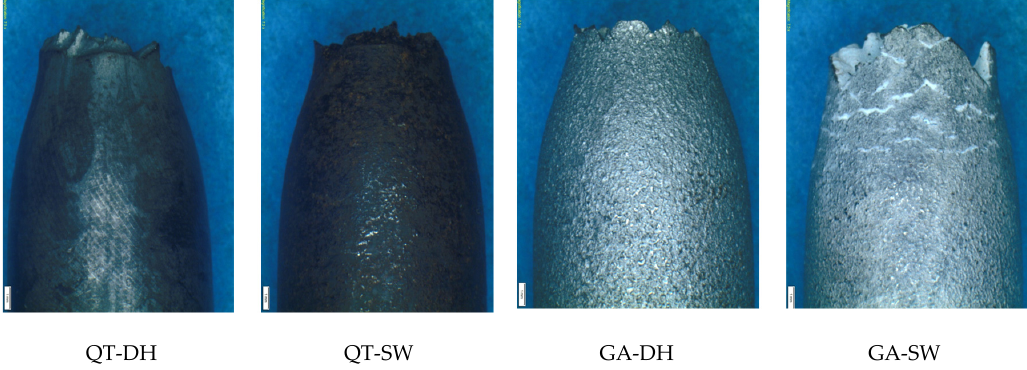
Figure 14. Pictures of the necking areas of representative SSRT specimens showing no EAC except for GA-SW.